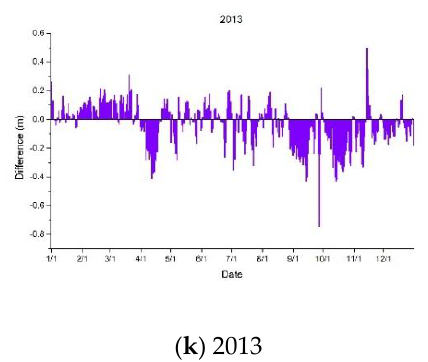
Figure 10. Water level difference between reality and simulation every year with ( a – k ) showing years 2003–2013, respectively.